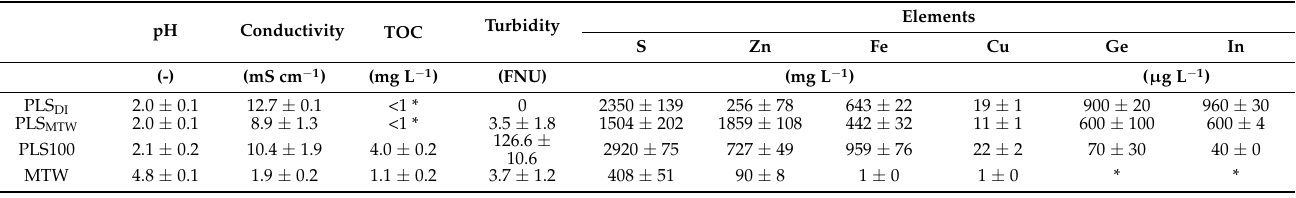
Table 4. Essential feed solution